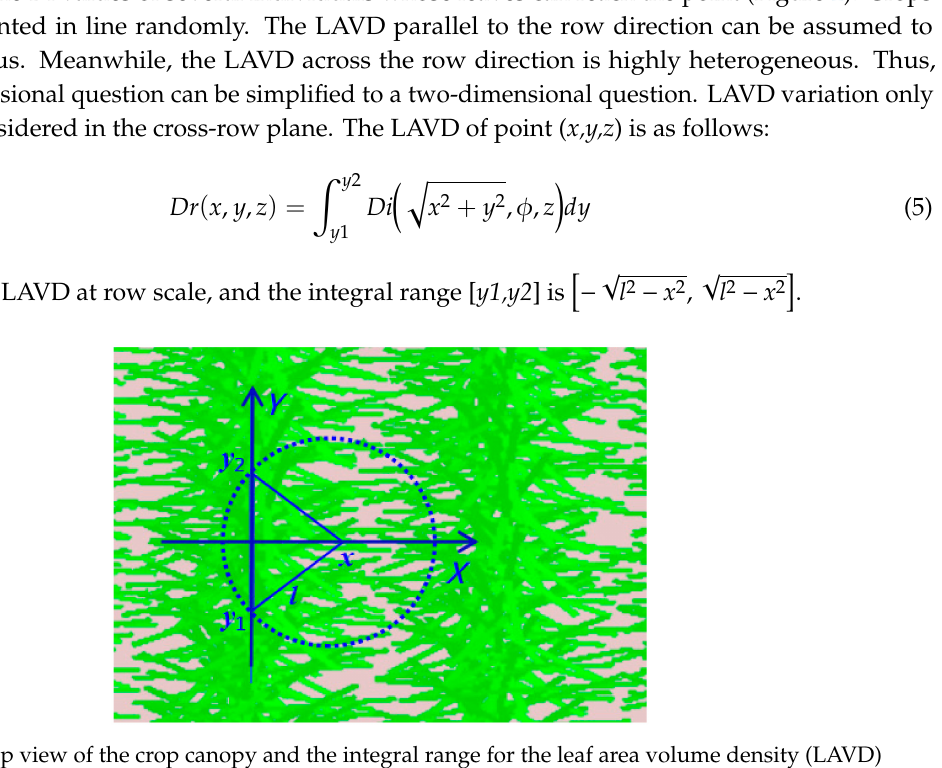
Figure 2. Top view of the crop canopy and the integral range for the leaf area volume density (LAVD) at the row